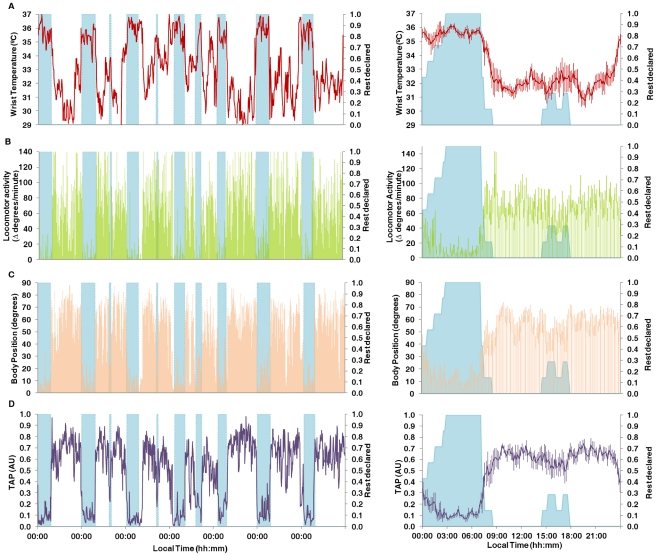
Individual weekly recording of all variables.Wrist temperature (A) in red, motor activity (B) in green, body position (C) in orange and TAP (D) in violet of a subject taken as an example, on the left. On the right it is represented the mean waveform of every variable for the same subject. Shaded blue areas coincide with sleep declared by subjects. On the right every variable is represented as value ± SEM.